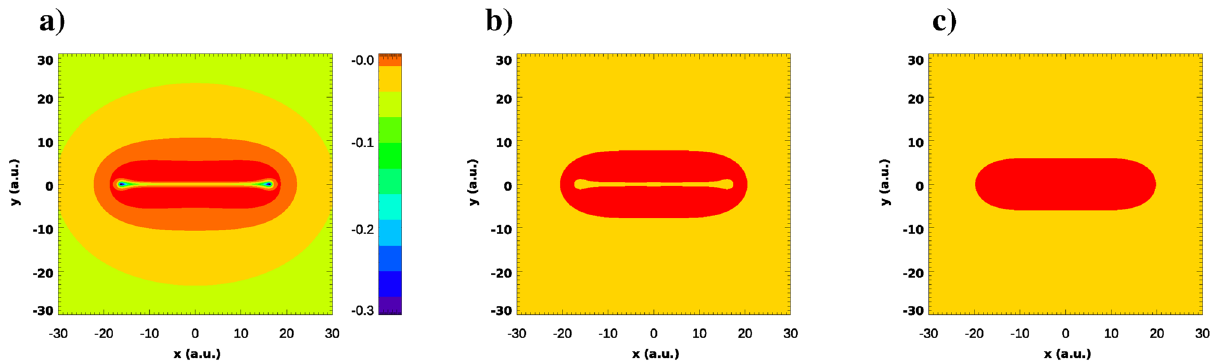
E V ( x , y ) (a.u.) in the KH atom for the IR field strength = − 0.0534 a.u. ( c ) Classically =